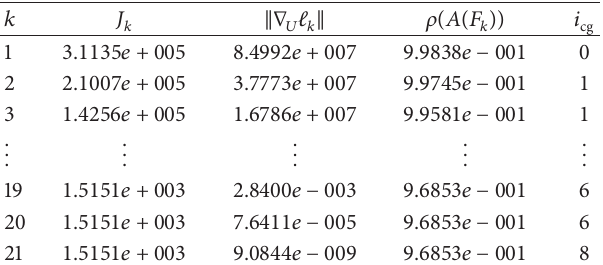
Table 1: Convergence behavior of the method DSQP for Example